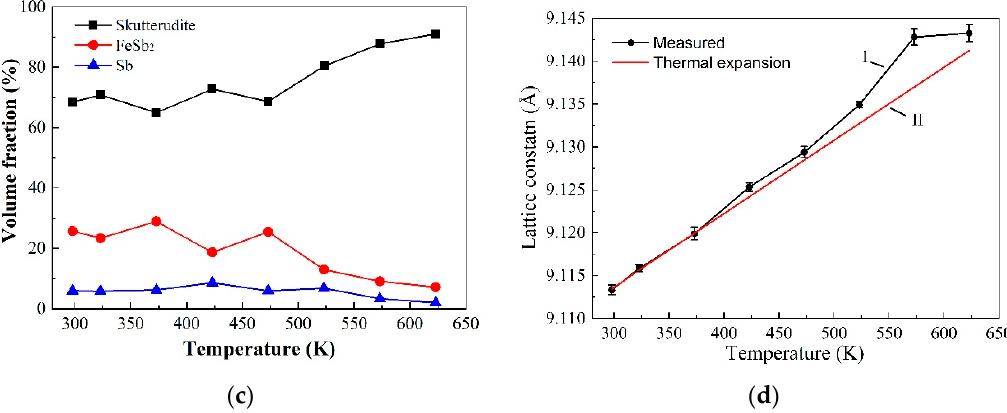
Figure 5. ( a , b ) The temperature-dependent XRD patterns of the spun ribbons. ( c ) The volume fraction of various phases at different temperatures. The skutterudite phase started to grow at a temperature as low as 473 K. ( d ) The lattice constant of the La-filled skutterudite phase at different temperatures, starting from 473 K. The increased La filling fraction also lead to the expanded lattice structure.